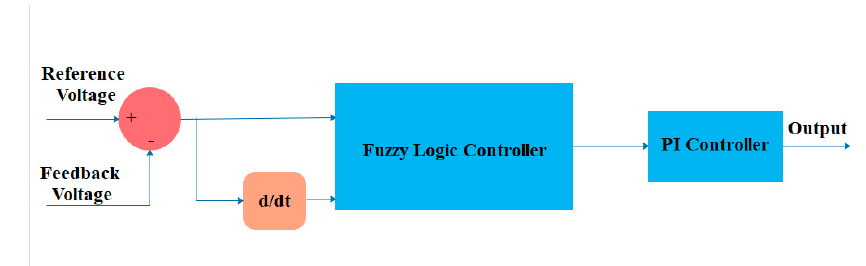
Figure 27. Voltage control block using proposed hybrid technique.